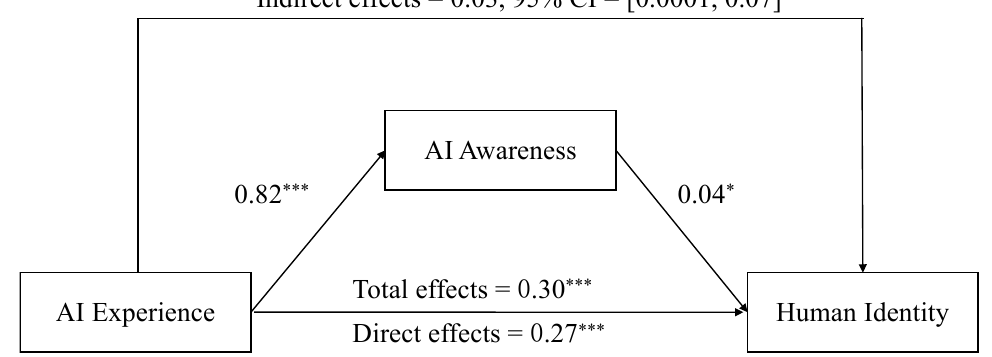
Figure 1. Mediating effect of artificial intelligence awareness. Note: * p < 0.05, *** p < 0.001.